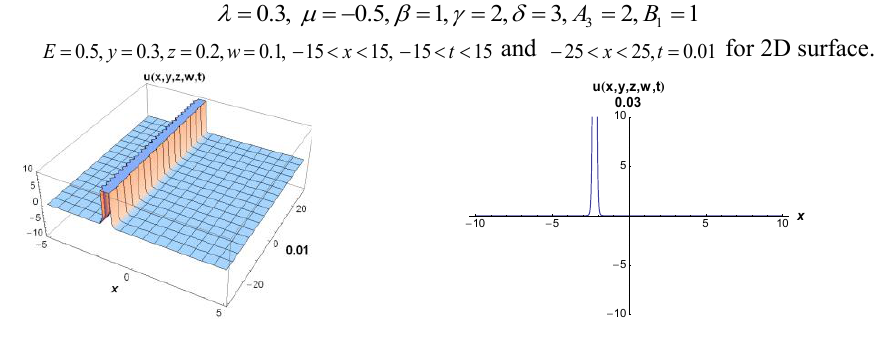
Fig.2. The 3D and 2D surfaces of Eq. (22)